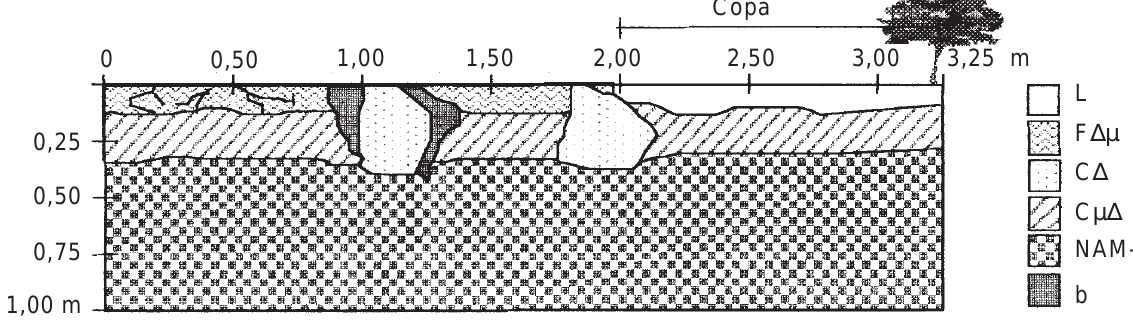
Figura 1. Perfil Cultural sob cultura de citros em LRd (Londrina-PR).